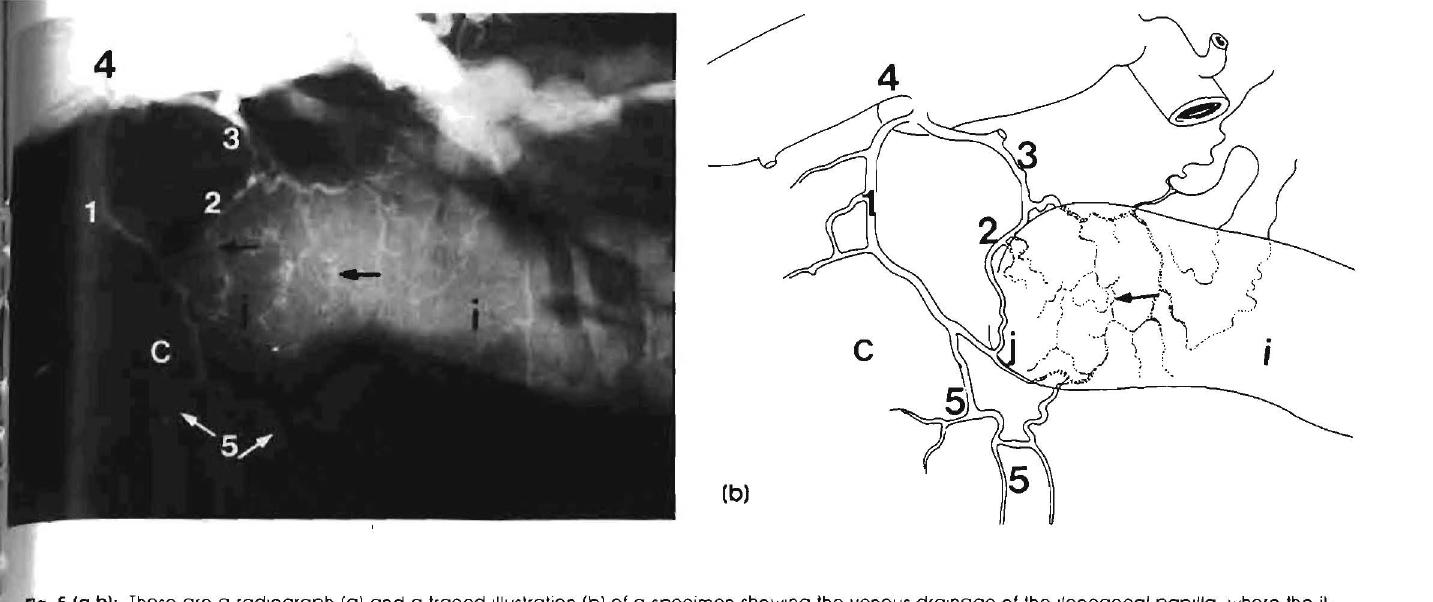
fig. 5 (a·b): These are a radiograph (a) and a traced Illustration (b) of a specimen showing the venous drainage of the Ileocaecal papilla. where the il· eocol,c vein has been Injected wllh a mlxlure of lalex and barium sulphate. The cranial and caudal veins are arranged in a circular fashion around Ihe base of Ihe papilla The Ileum (I). enlers Ihe caecum (c). atlhe ileacaecal junclion U) The cranial vein of the papilla IS marked (I). the dorsal vein (2). Ihe caudal vein (3). Ihe laleral caecal vein (4). Venous branches draining Ihe caecum around Ihe junclion. and joining the cranial and caudal veins are marked (5) The venous plexus In the ileocaecal papilla IS indicaled with